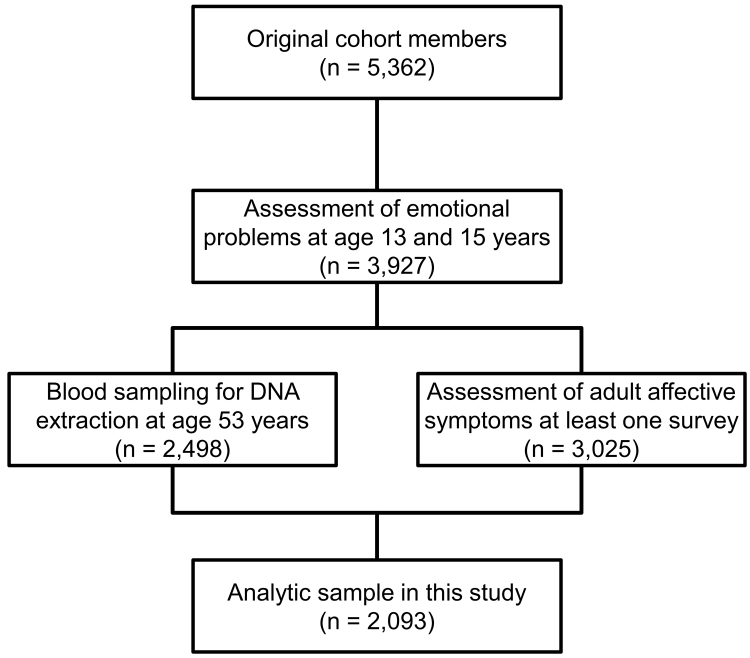
Participants flow in this study.